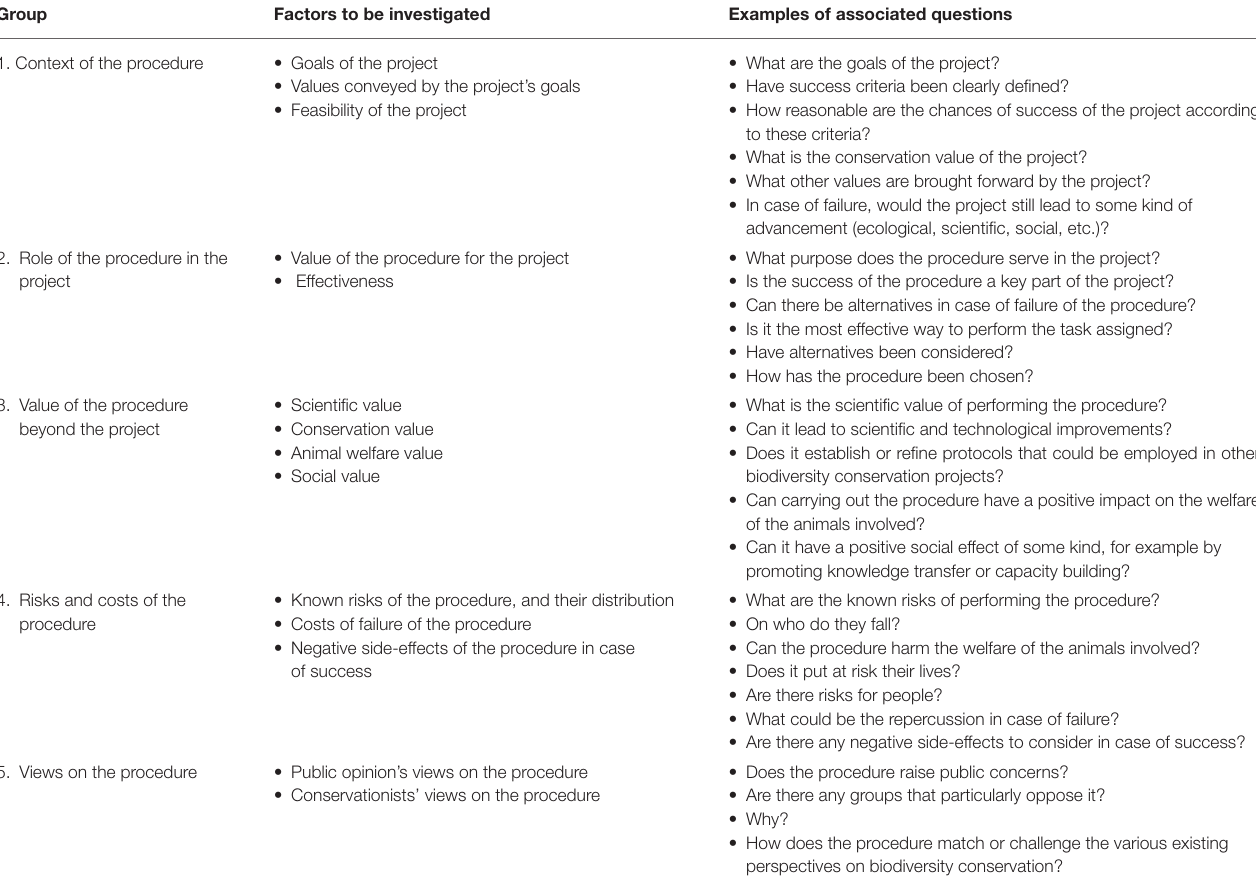
TABLE 1 | Relevant factors for the ethical analysis of conservation ARTs.